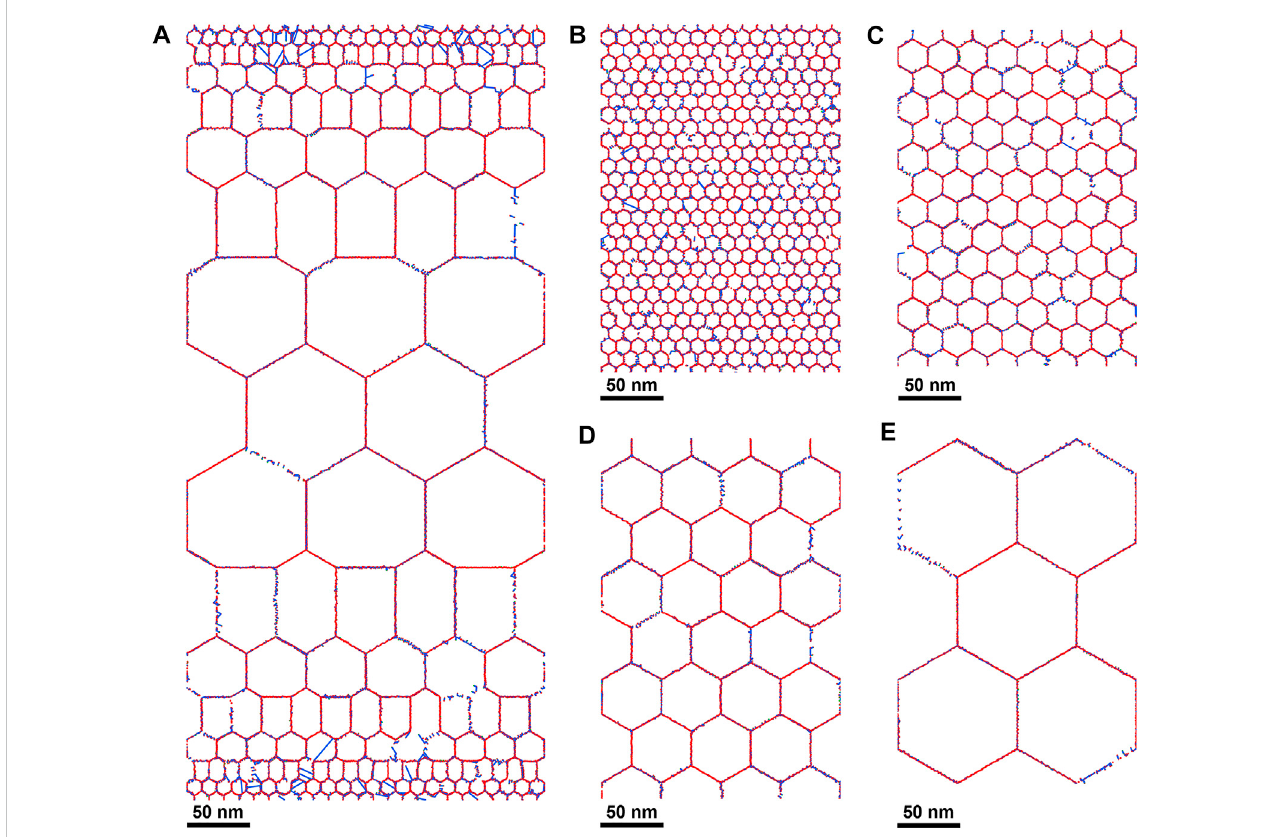
FIGURE 1 Therelaxedtensilecon fi gurationof (A) GNGstructuredmodelandpartsofhomogeneousNGstructuredmodelswith (B) 12 nmgrains, (C) 24 nmgrains, (D) 48 nm grains and (E) 96 nm grains.